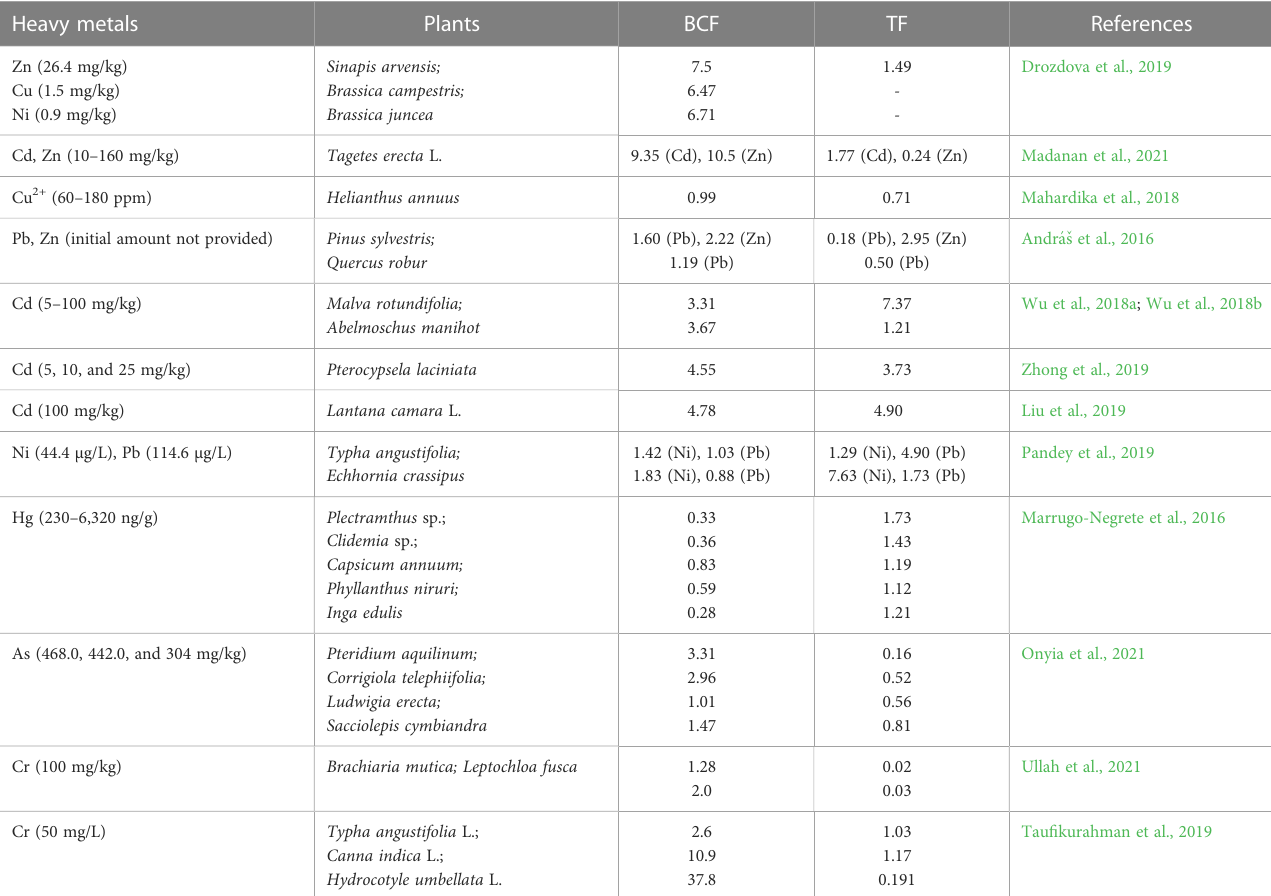
TABLE 1 List of some plants used in the phytoremediation of different soil contaminants. Heavy metals